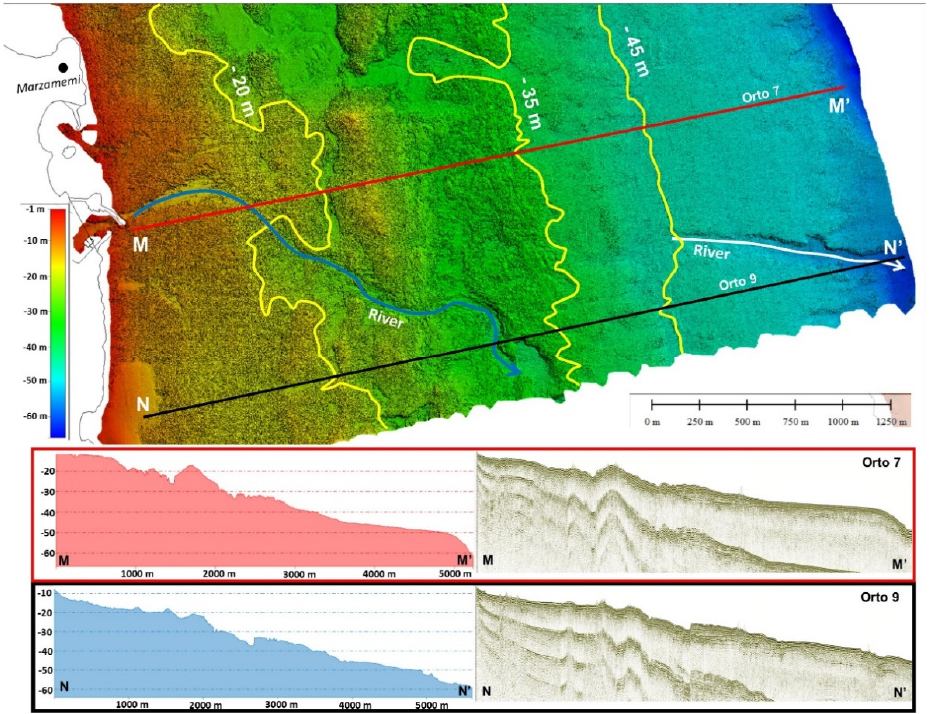
Figure 13. Visualization of the main features of the southern sector of the study area. The M–M ′ and N-N ′ bathymetric profiles and the seismic profiles of Orto 7 and Orto 9 show all the morpho-stratigraphic settings of this sector.